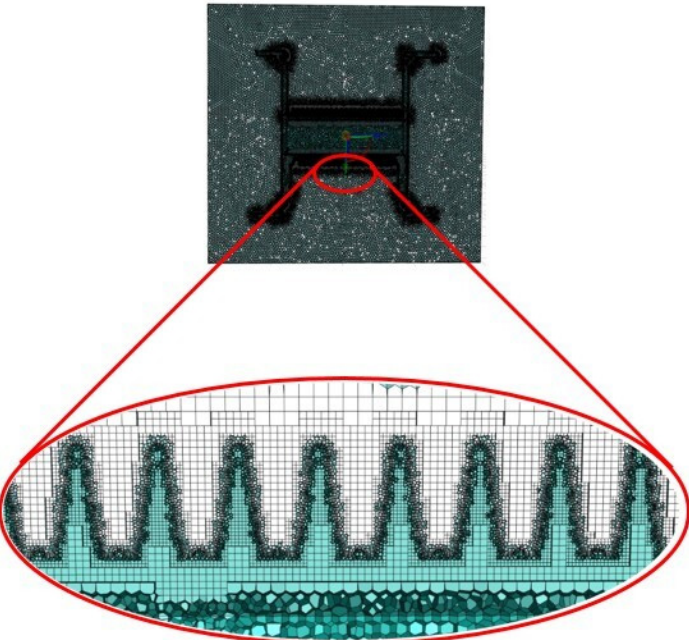
Figure 2. Mesh grid of the model and detail of three boundary layers around the heat sink.